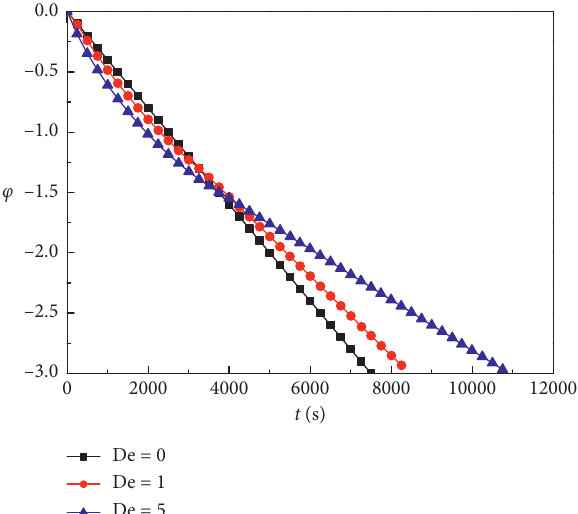
Figure 6: The interfacial tension obtained using the data of t < 3500 s, t > 3500 s, and the whole